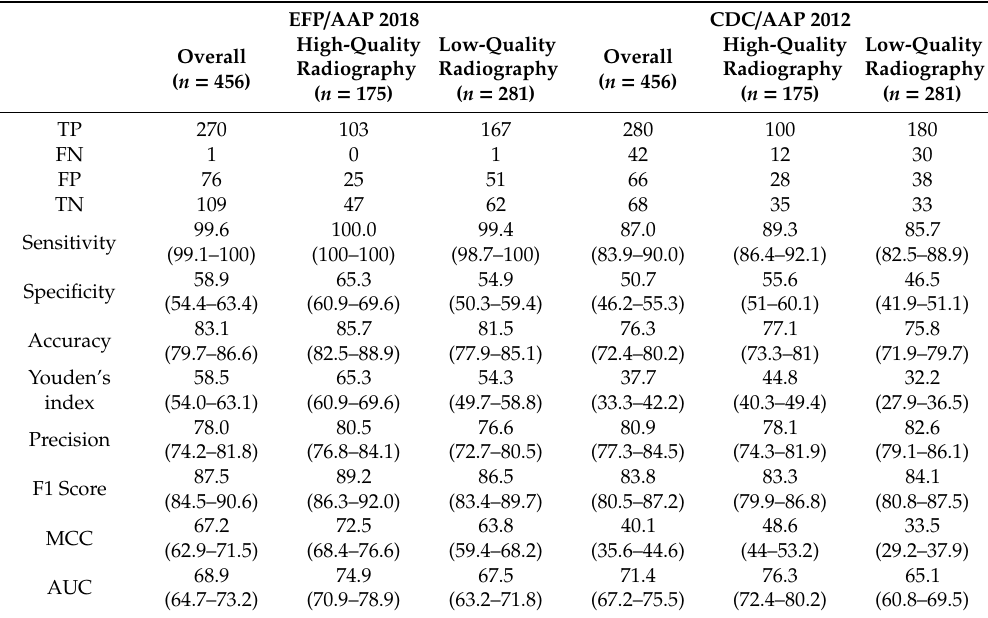
Table 3. R-PBL performance analysis according to the EFP / AAP 2018 and CDC / AAP 2012 case definitions ( n = 456). Values are expressed as mean and 95% Confidence Interval (95% CI).